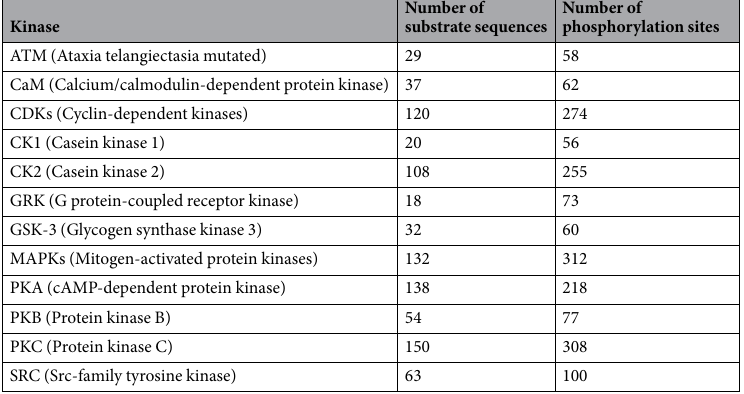
Table 1. Statistics of human kinase-specific substrates and their phosphorylation sites, derived from the Phospho.ELM database (version